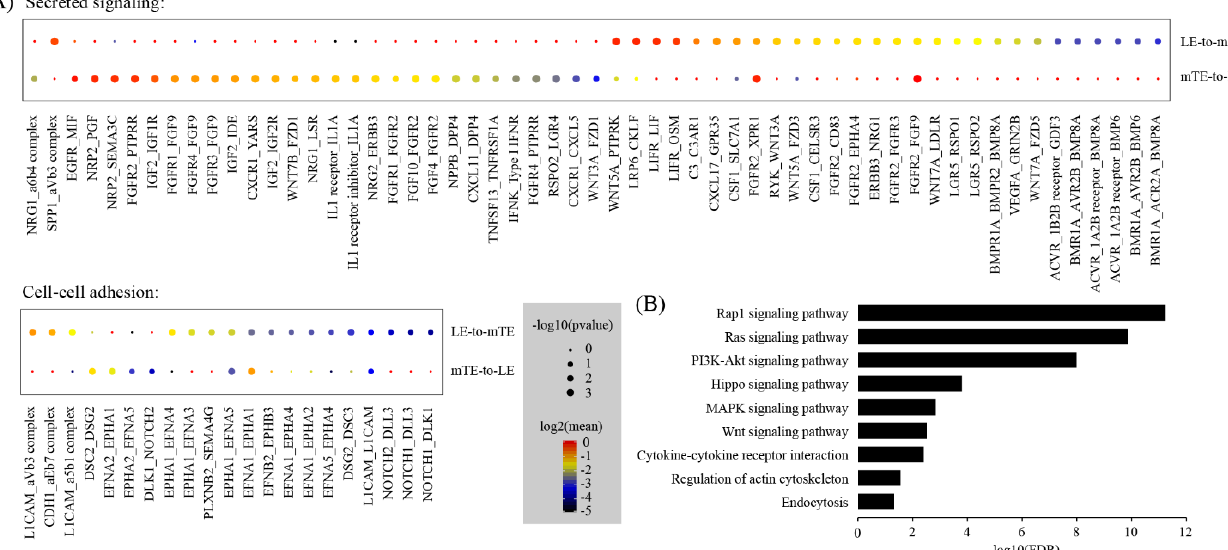
Figure 5. Cell–cell communication between mTE and LE: ( A ) Dot plot showing selected ligand–receptor interactions underlying mTE-LE crosstalk. p -values are indicated by circle size and means of the average expression level of interacting molecule are indicated by color; ( B ) KEGG Pathway enrichment analysis of ligand–receptor pairs by using the DAVID online tools.